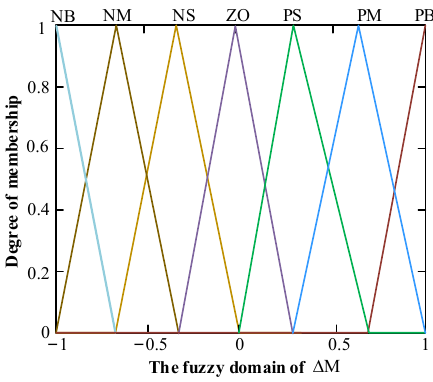
    ∆ β and ∆ . ϕ . and . Figure 4. The fuzzy domain of